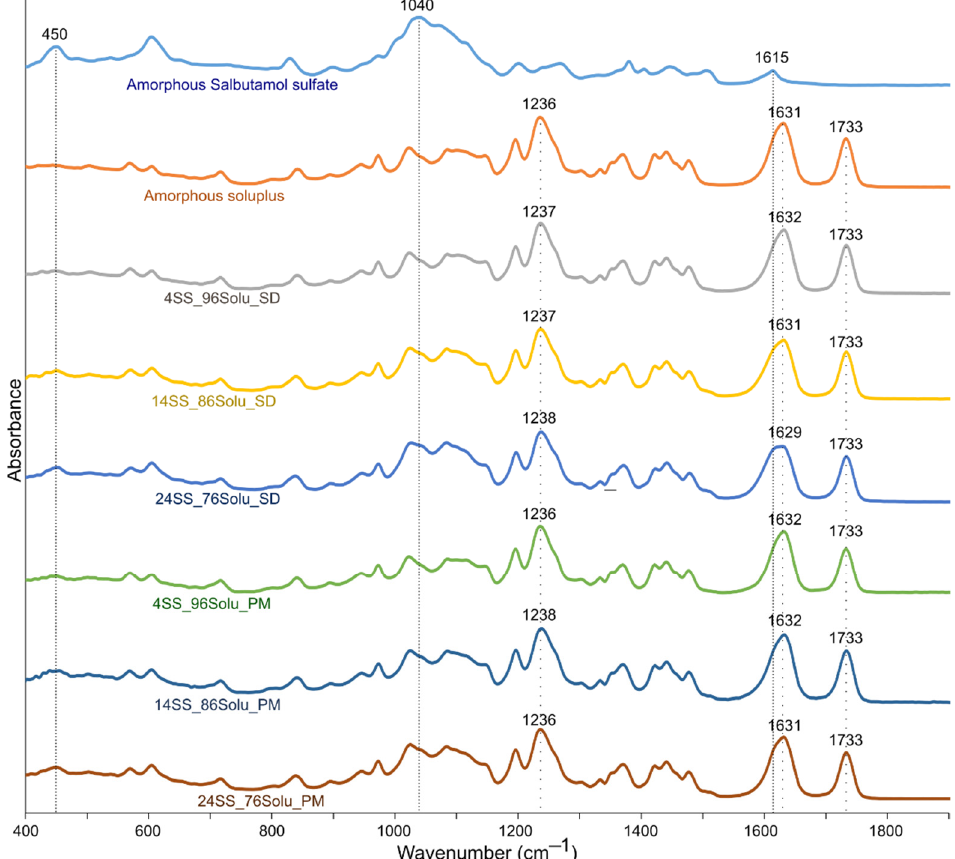
Figure 3. FTIR spectra of the various amorphous spray-dried powders (amorphous salbutamol sul- fate, amorphous soluplus, 4% salbutamol/96% soluplus (4SS_96Solu_SD), 14% salbutamol/86% soluplus (14SS_86Solu_SD), 24% salbutamol/76% soluplus (24SS_76Solu_SD)) and their physical mixtures (4% salbutamol/96% soluplus (4SS_96Solu_PM), 14% salbutamol/86% soluplus (14SS_86Solu_PM), 24% salbutamol/76% soluplus (24SS_76Solu_PM)).